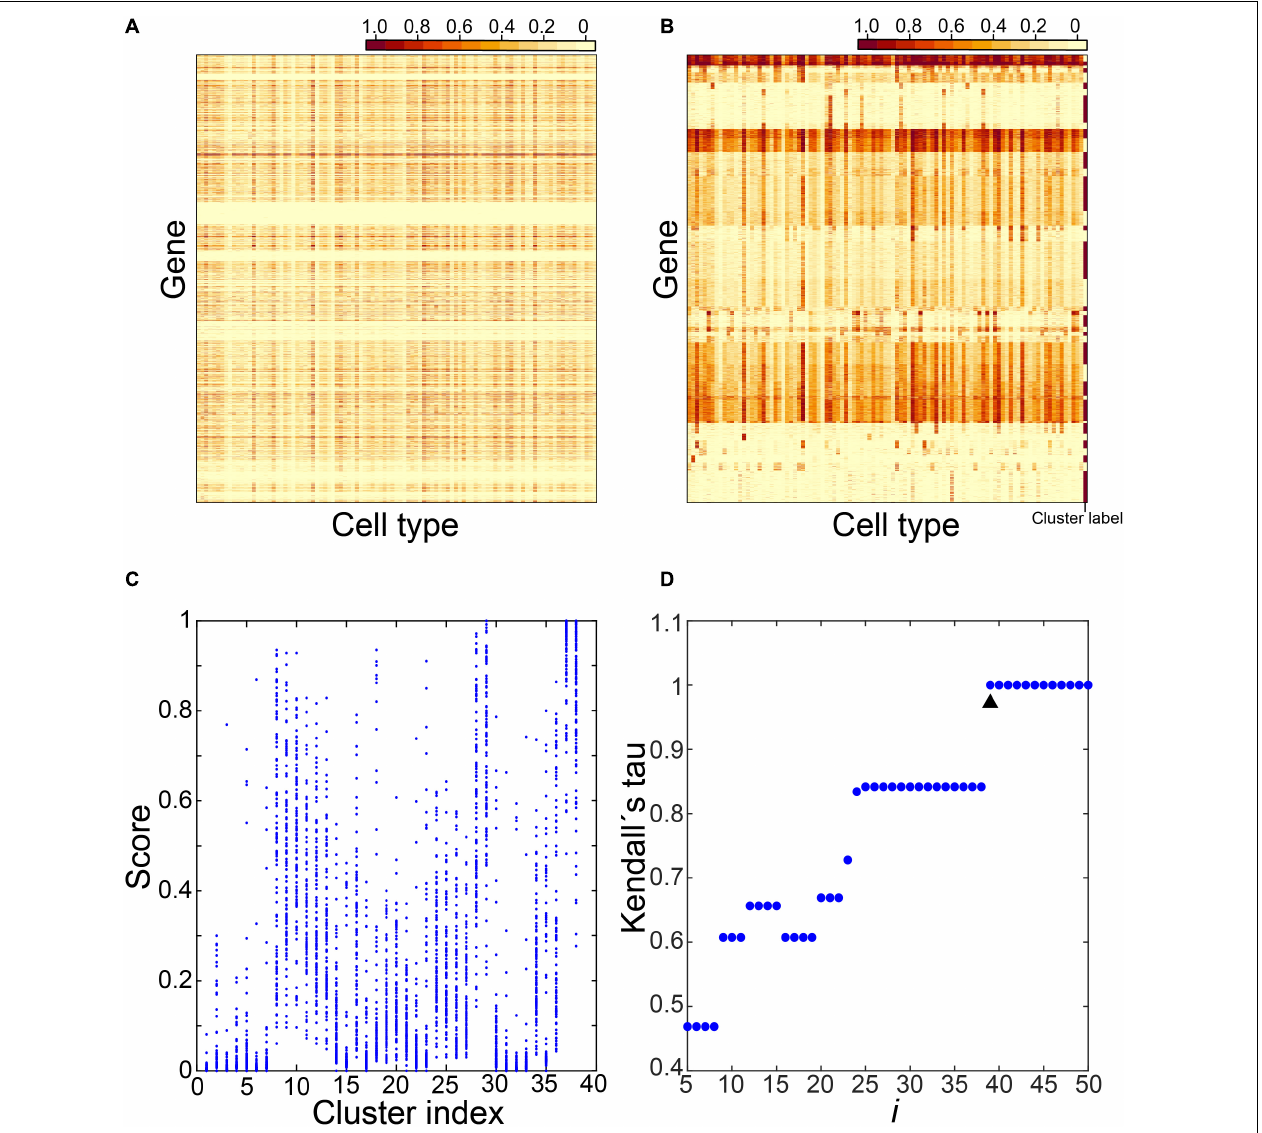
FIGURE 1 | Identification of cell type–specific (CTS) gene clusters. Five steps were involved in identifying CTS gene clusters. The expression values of genes across the 101 cell types in step 1 (A) , the expression heatmap of the gene clusters over the 101 cell types in step 2 (B) , the expression scores of the gene clusters over the 101 cell types in step 3 (C) , and the Kendall rank correlation coefficient between gene clusters under different cluster parameters (D) were